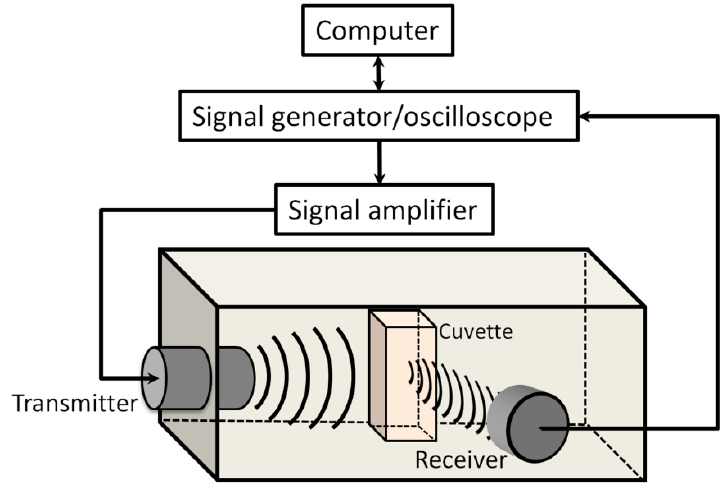
Figure 1. Experimental setup designed for sonoporation studies.